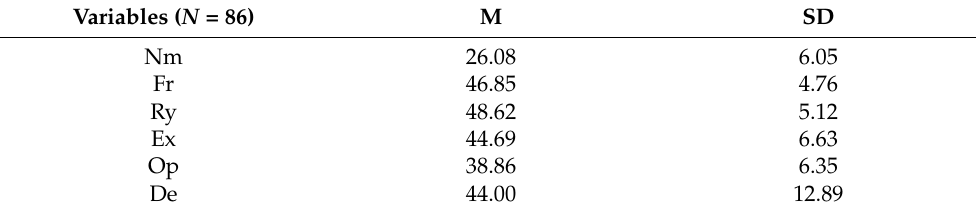
Table 1. Descriptive study of the personality and depression